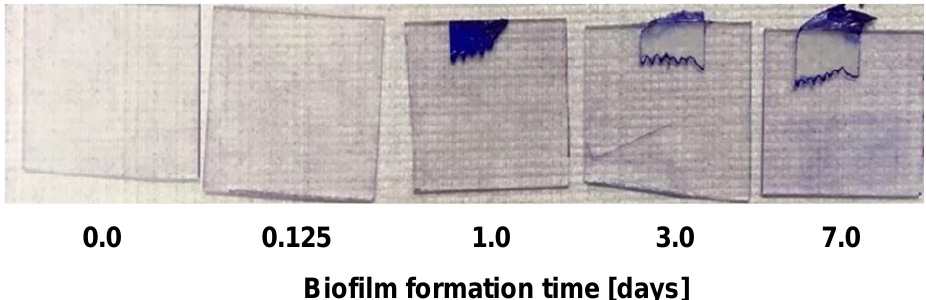
Figure 6. Crystal violet dye staining of biofilm formed on glass substrates. Figure 5. Variation of deposited Ag and biofilm formation with time.